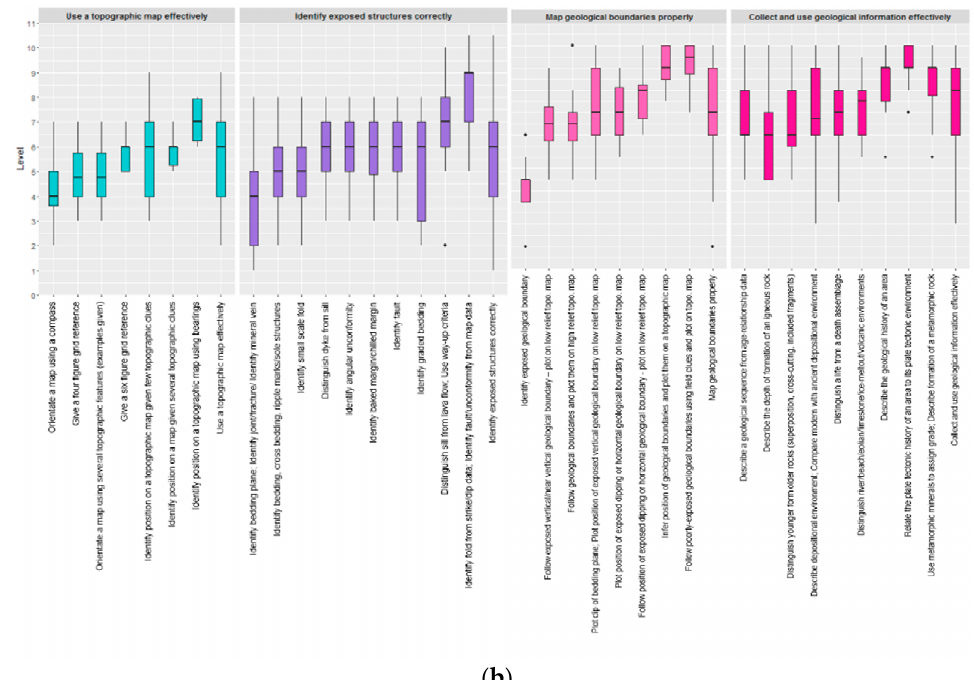
Figure 1. (a) Boxplot of the median data for the four strands with the lowest medians. For each strand in Figures 1a and 1b, the boxplot on the right-hand side is the median for all the data in that strand. The strands are presented in order, from the one with the lowest median to the left rising to the one with the highest median at the right. For each strand, the items step up in difficulty, according to the median, from left to right; (b). Boxplot of the median data for the four strands with the highest medians.). Table 4. Summary of feedback on the questions ‘Is there a progression in this element of Earth science fieldwork?’ and ‘How easy was it to assign National Curriculum for Science (NCS) levels?’ for each